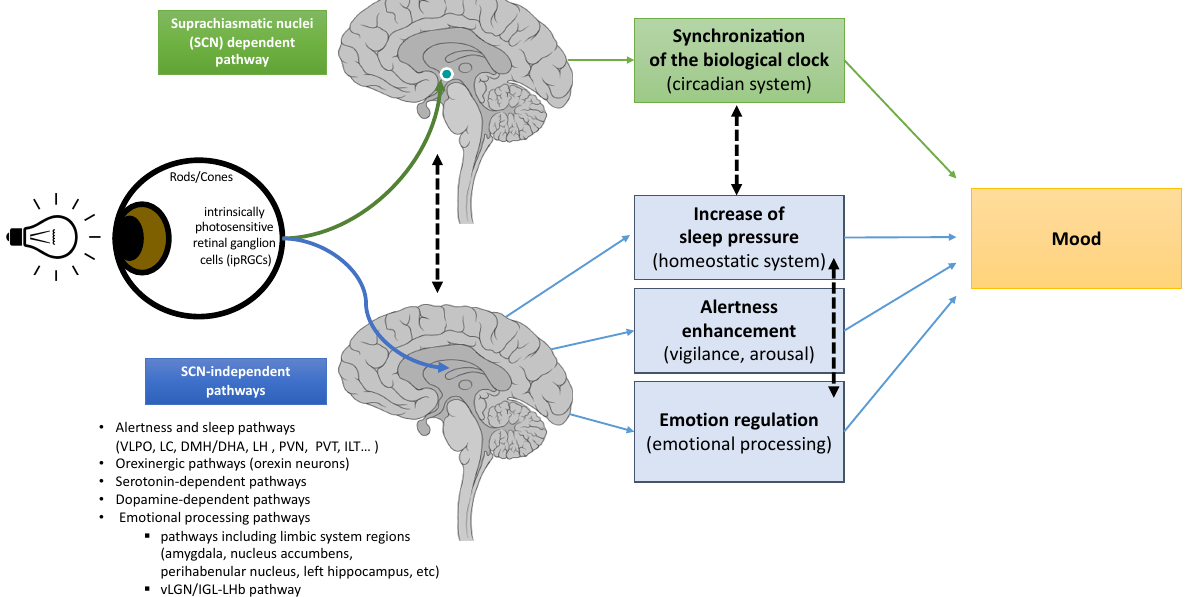
Figure 1. Multi-level processes and retina–brain pathways of photic regulation of